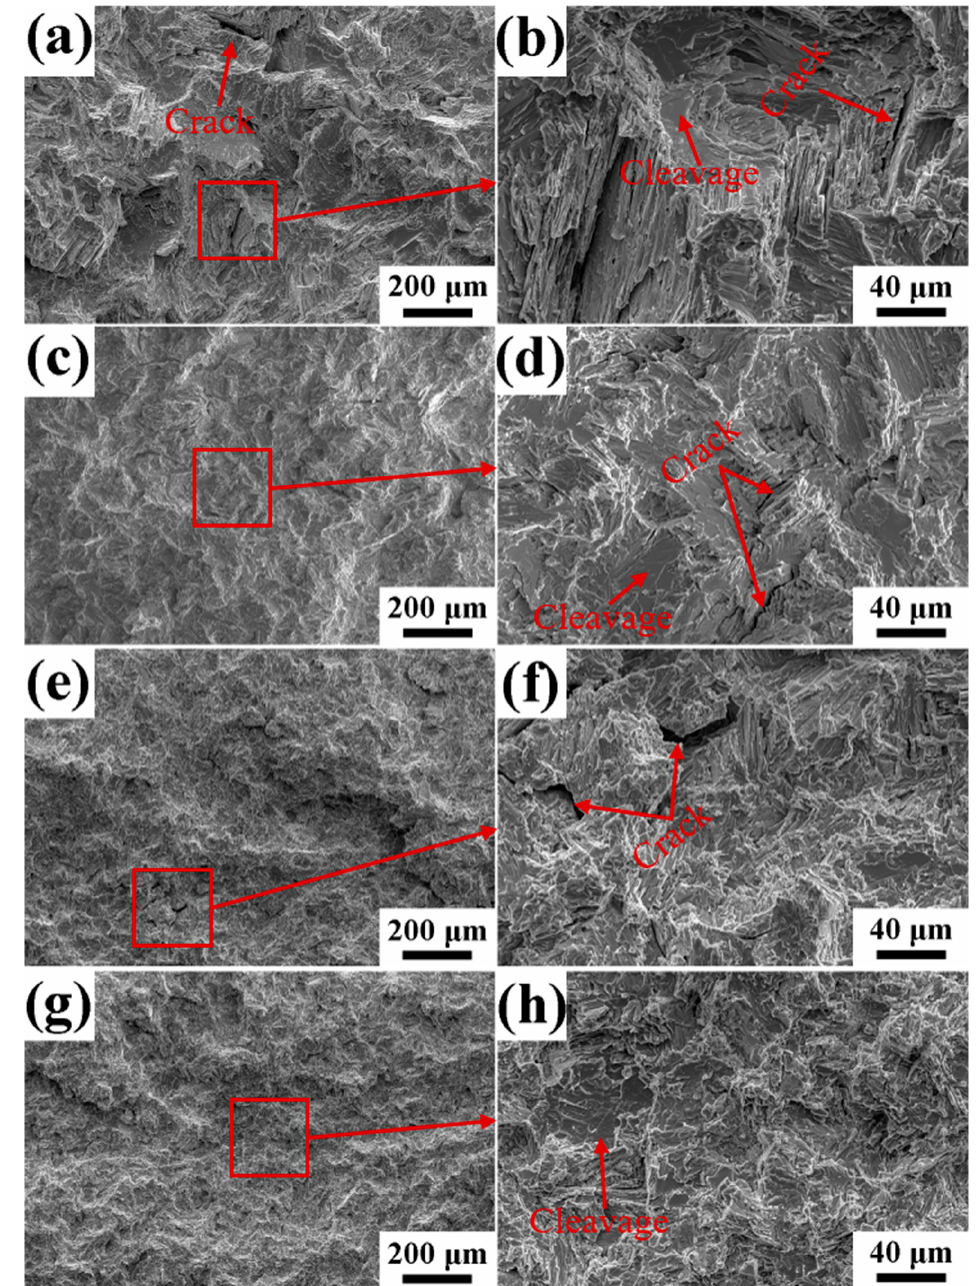
Figure 9. Tensile fracture morphology at 800 °C: ( a , b ) 0 at%; ( c , d ) 0.05 at%; ( e,f ) 0.10 at%; ( g,h ) 0.20 at%.